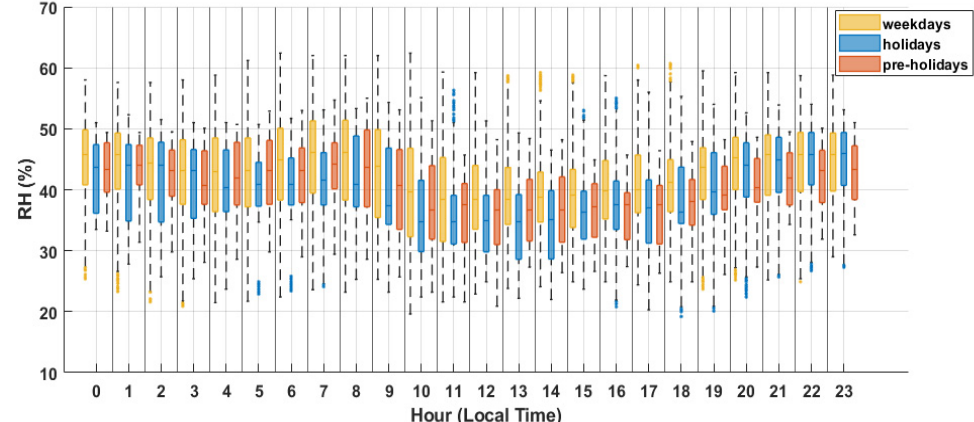
Figure 6. RH distribution boxplot in the three months April–June, differentiating among weekdays (orange), pre-holidays (red) and holidays (blue).